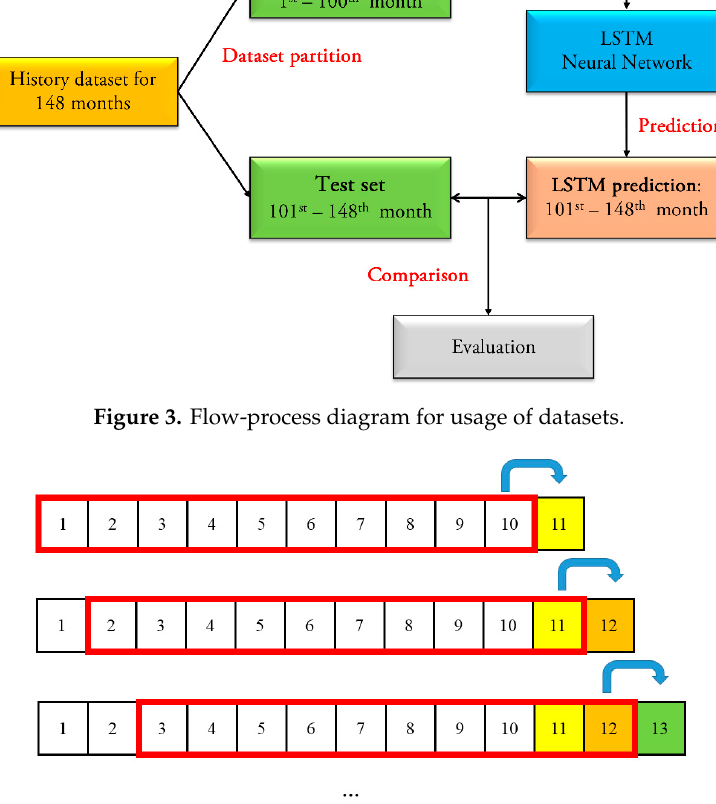
Figure 4. Illustration of the LSTM calculation process.